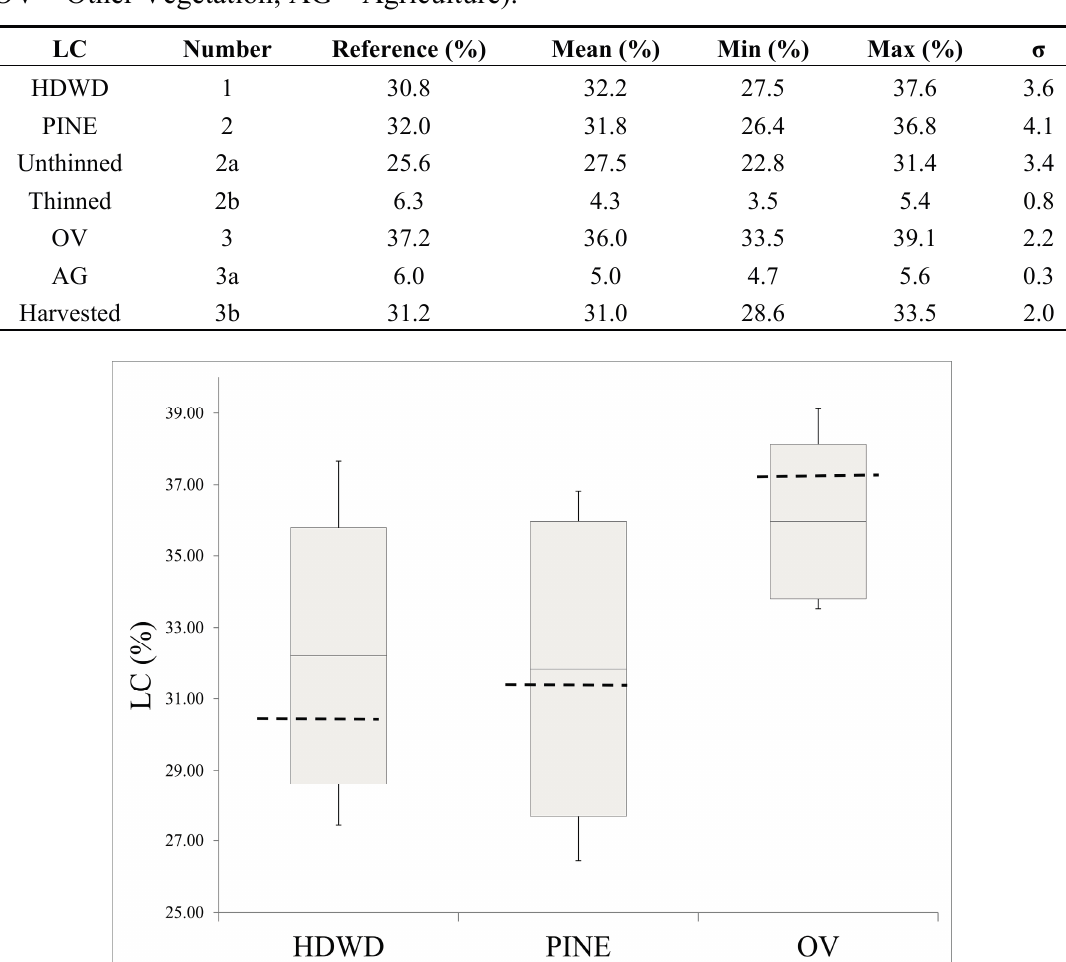
Figure 8. Land cover variability (n = 6) for the classification of 1-km 2 subset of Landsat 7 ETM+ image, Appomattox, Virginia. Dashed line signifies reference value for each LC